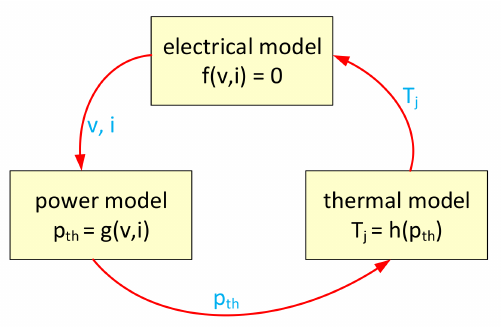
Figure 1. General form of the compact electrothermal model of a semiconductor device dedicated for